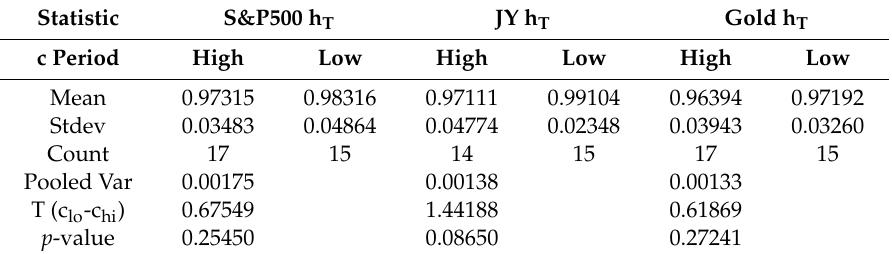
Table A3. High and low ($) c period ($) h T s (and their di ff erence).